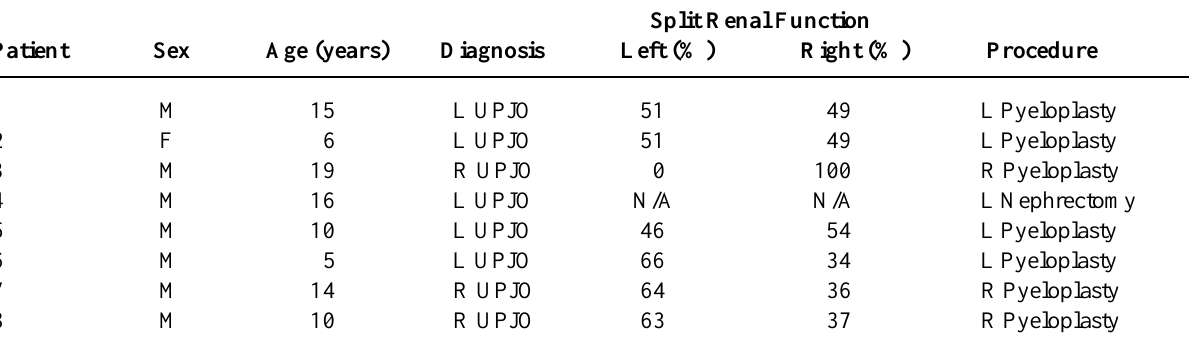
Table 1 – Patients with left (L) or right (R) ureteropelvic junction obstruction (UPJO) and abdominal pain presented in chronological